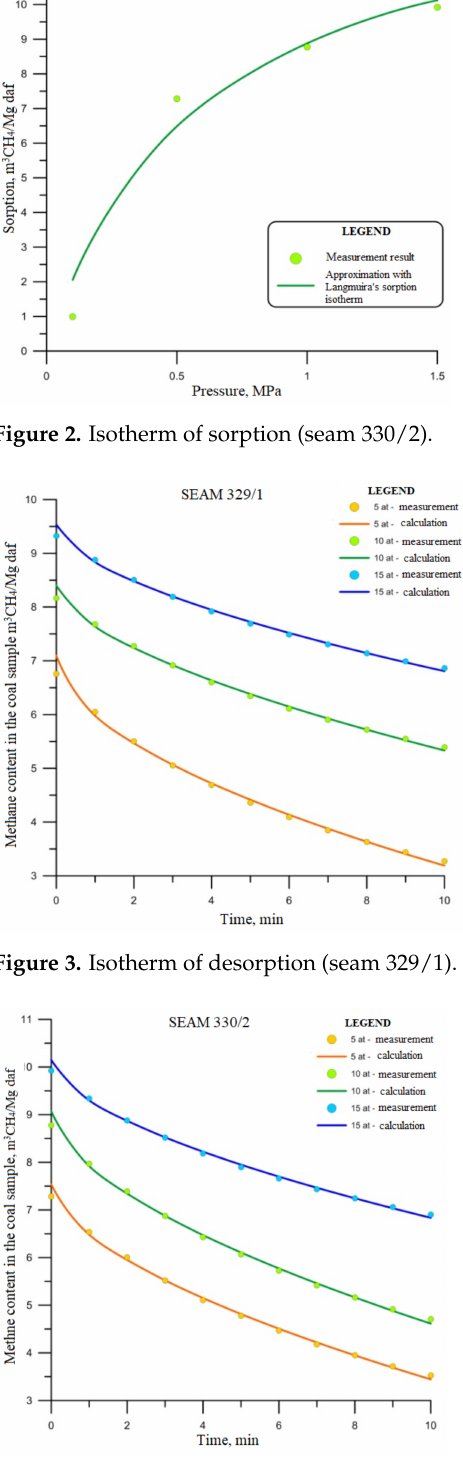
Figure 4. Isotherm of desorption (seam